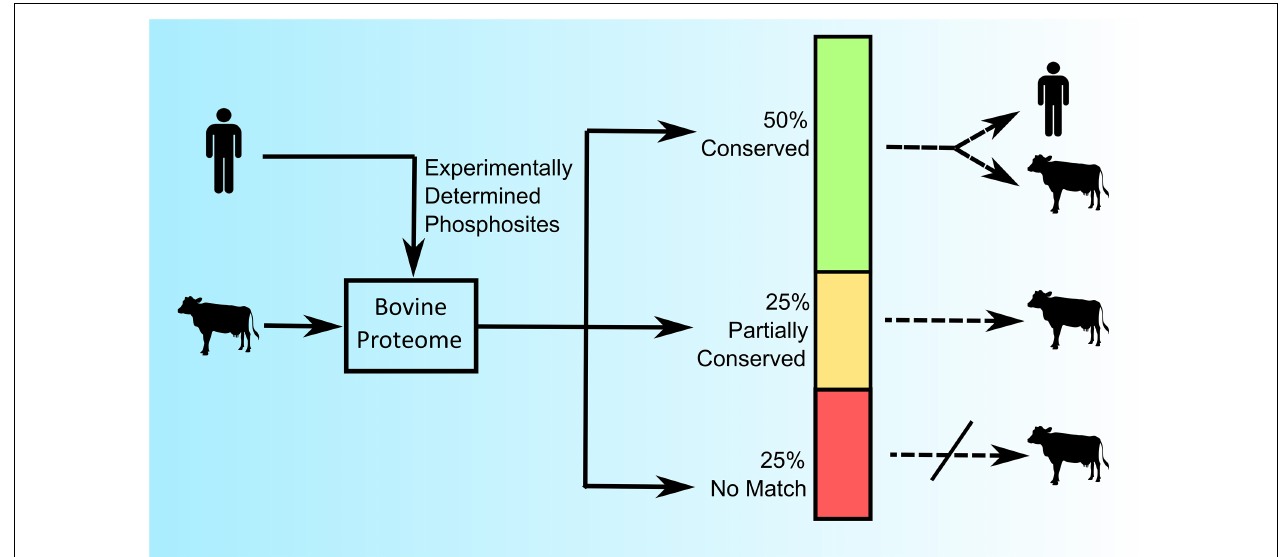
FIGURE 1 | Comparative analysis of conserved and species-specific phosphorylation sites in the human and bovine proteome. Nearly 1,000 experimentally determined human phosphorylation sites (15 amino acids in length) from PhosphoSite were queried against the Bos taurus proteome using BLASTp (version 2.2.13) to identify protein homologs. “Conserved” represents 100% amino acid sequence identity; “Partially Conserved” represents less than 3 mismatches in the amino acid sequence; and “No Match” represents no identified homolog in the bovine proteome